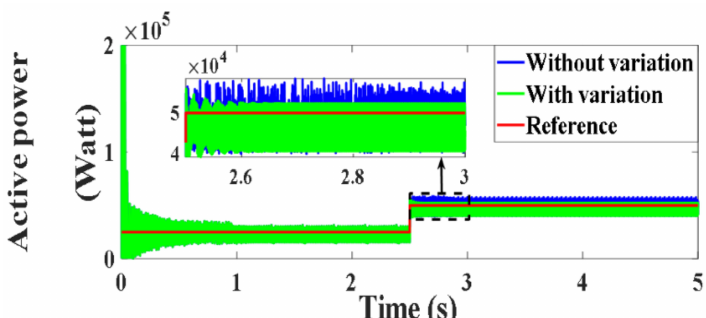
Figure 145. Active power under PVC (Watt).